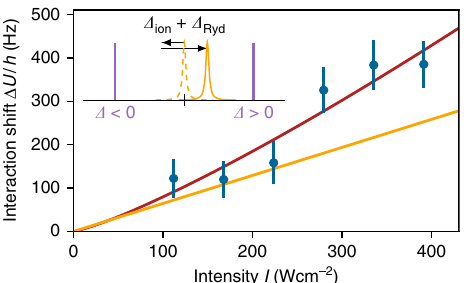
Fig. 5 Interaction effects of a Rydberg optical Feshbach resonance. Dependence of the measured scattering length a = U / U ref a bg on the fi nal lattice depth for red detuning Δ = − 2 π × 17 MHz (inset for blue detuning Δ = 2 π × 18 MHz). While our two-level theory (orange) has a near constant behavior the experimental scattering length increases with increasing lattice depth for both blue and red detuning. We attribute this to background Rydberg excitations leading to a shift of the photoassociation resonance (see text). Error bars in the scattering length correspond to the statistical errors from the fi tting procedure. Error bars in the lattice depth (±1 E rec ) are an estimated systematic